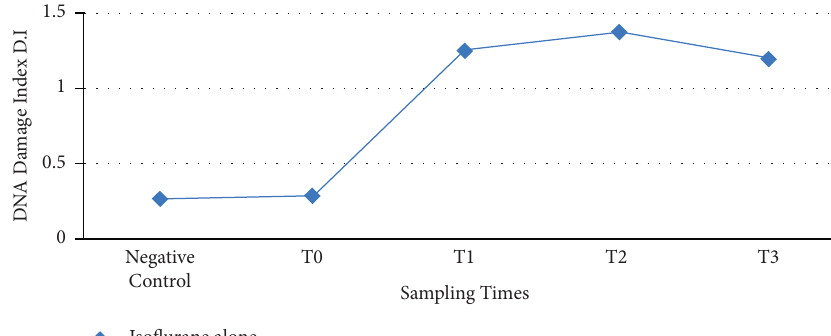
Figure 2: Graphical representation of the genotoxic potential of ISO alone ( n � 12). T � just before the anesthesia induction (baseline), 0 T 1 � at 4hours after anesthesia induction. T 2 � at 8hours of anesthesia induction, T 3 � at 16hours of anesthesia induction. Table 2: Genotoxic potential and genetic damage index of ISO +DEX balanced anesthesia ( n � 12). Genotoxic potential Genetic damage index Sr.